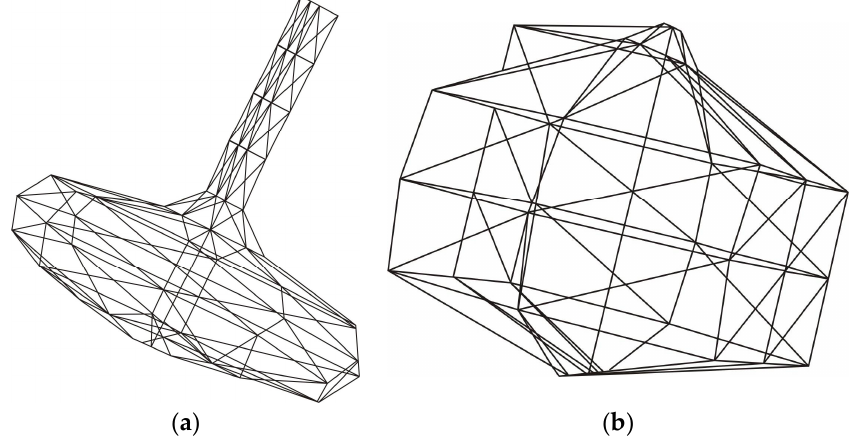
Figure 8. ( a ) Linear 3D model of the borehole; ( b ) Linear 3D model of the resulting expansion of the borehole [4].